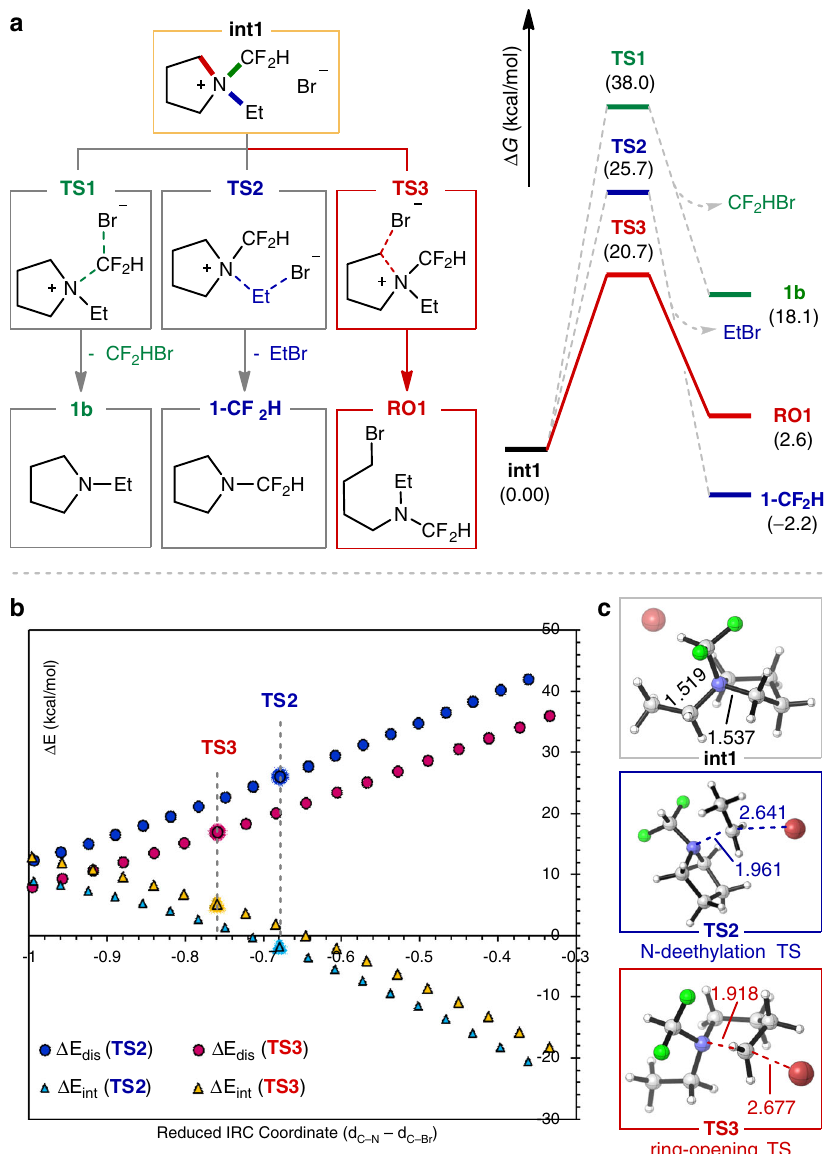
Fig. 4 Evaluation of selectivity for 5-membered cyclic amines with DFT calculation. a Reaction energy pro fi les of three possible nucleophilic substitution pathways from N -CF 2 H salt ( int1 ); green: dedi fl uoromethylation path leading to 1b (via TS1), blue: deethylation path leading to 1-CF 2 H (via TS2), and red: ring-opening path leading to RO1 (via TS3). b Distortion-interaction analysis along IRC coordinate of int1 ; blue dot: distortion energy of deethylation, red dot: distortion energy of ring-opening, sky blue triangle: interaction energy of deethylation, and yellow triangle: interaction energy of ring-opening. c DFT- optimized structures of int1 and its transition states for deethylation (blue, TS2) and ring-opening (red,